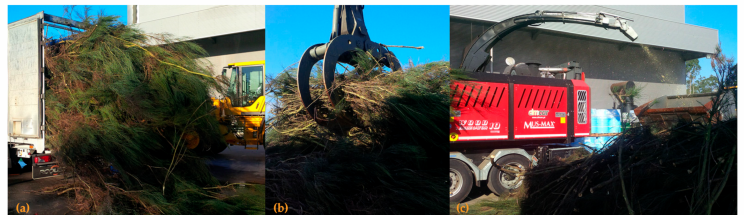
Figure 1. Moments of unloading the biomass bales of C. striatus in the park of the industrial pellet production unit. ( a ) Truck unloading the biomass bales; ( b ) preparation of the bales for the shredding; ( c ) shredding